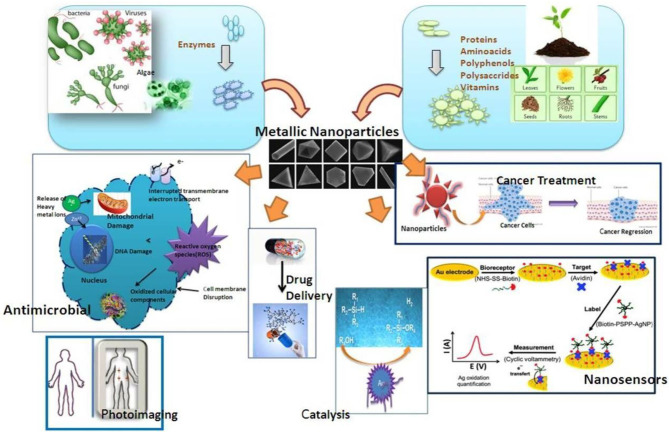
Application of Green synthesis of metallic nanoparticles.